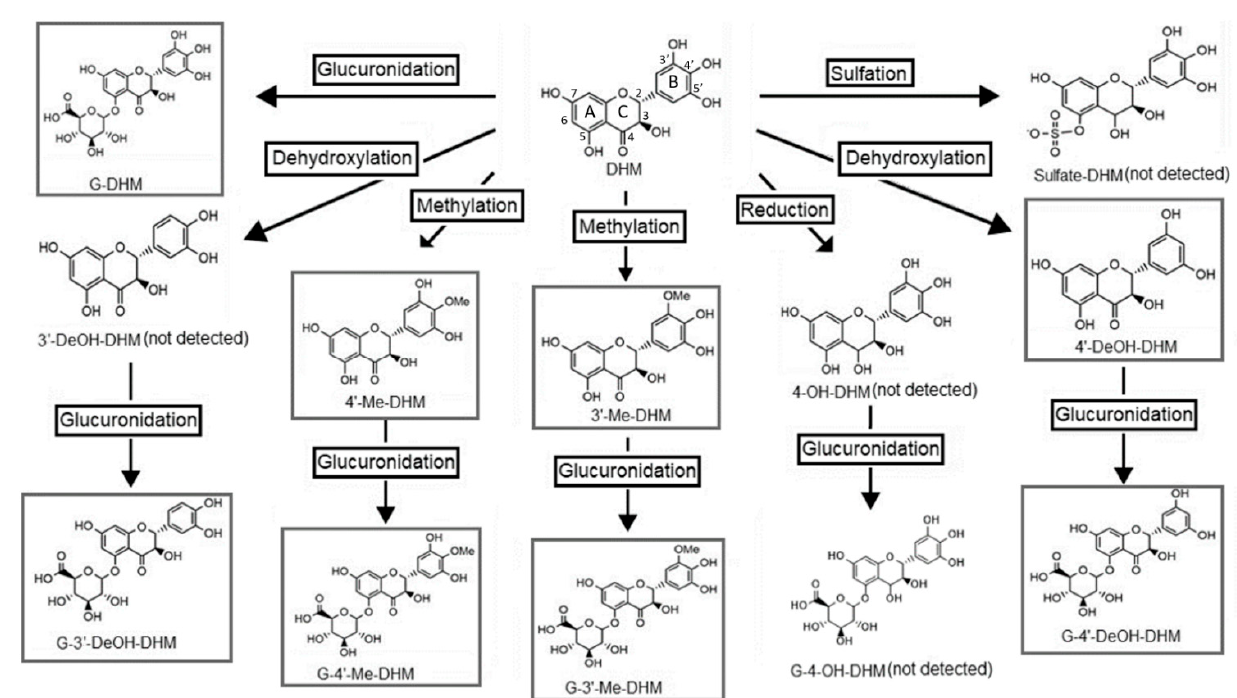
Figure 3 . Proposed metabolic pathway of dihydromyricetin (DHM) based on detection of metabolites in feces and/or urine samples of rats [31,32]. Boxed compounds are those that were detected in this study. Table 2. Intrinsic GABA A R activity of DHM, 4 (cid:48) -Me-DHM, 3 (cid:48) -Me-DHM and 4 (cid:48) -DeOH-DHM in α 5 β 3 γ 2 expressed in Xenopus oocytes in the presence of